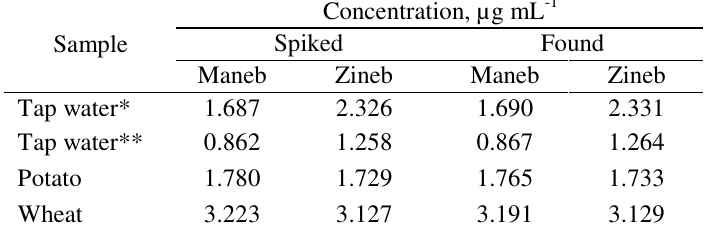
Figure 3. H-point standard addition plots for fixed zineb concentration (1.655 µg mL -1 ) and different concentrations of maneb. Table 2. Determination of maneb and zineb in different samples by